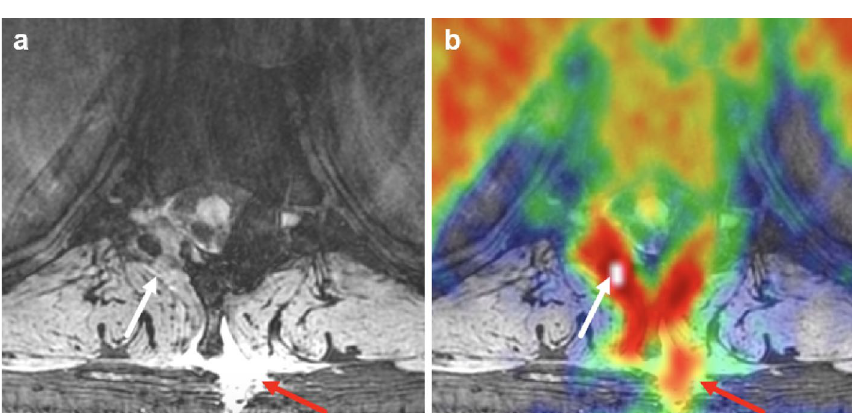
Figure 4. PET/MRI showing abnormalities at the level T10, especially at the site of a right-sided laminotomy, in patient with suspected cerebrospinal fluid leak. Axial DESS MRI ( a ) at T10 level of Patient 6 shows right- sided laminotomy (white arrow) with fluid collection (red arrow). Increased [18F]FDG uptake (white arrow, SUV max = 4.6) is visible on PET/MRI ( b ) in areas corresponding to osseous tissue and neuroforamina. In addition, focal fluid collection is observed around the spinous process, which also has increased [18F]FDG uptake (red arrow, SUV max = 2.6).